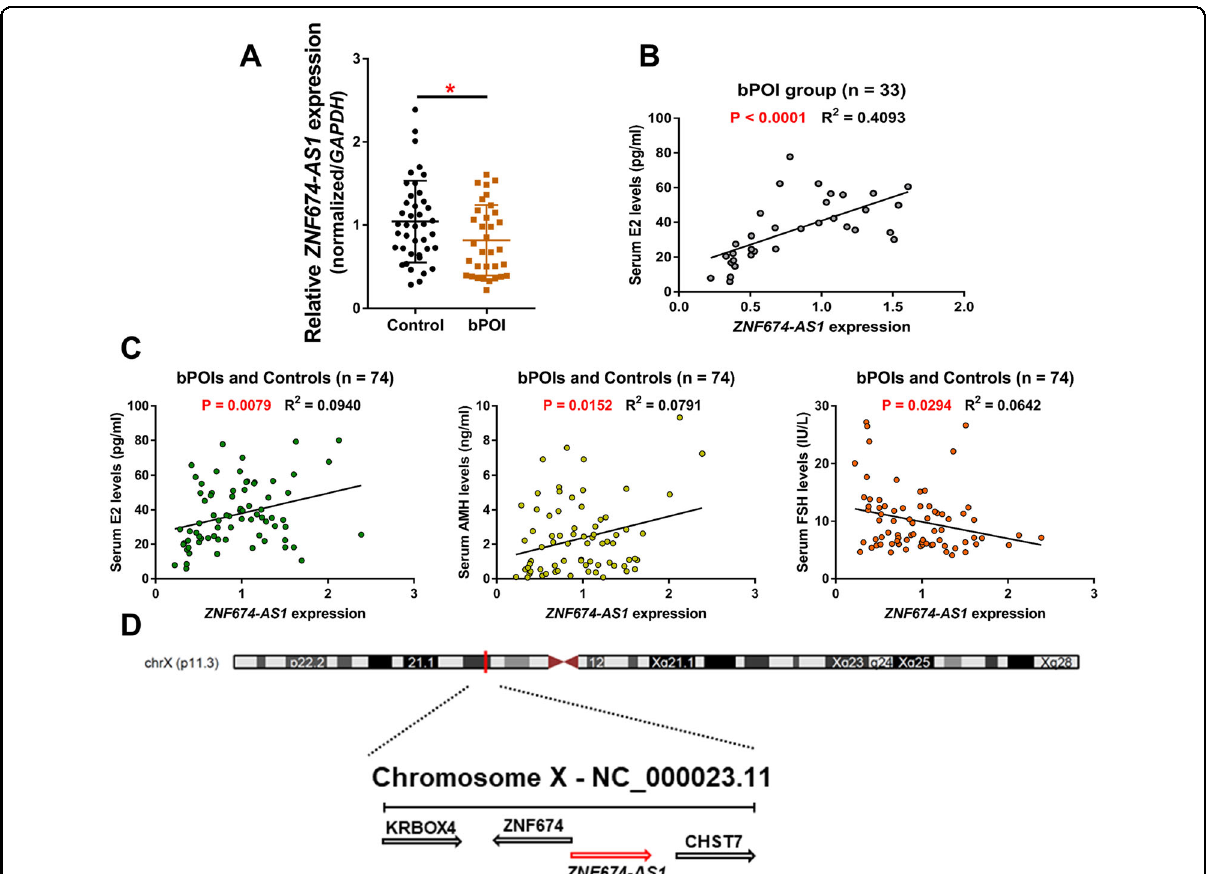
Fig. 1 LncRNA ZNF674-AS1 is down-regulated in GCs from patients with bPOI and correlates with poor ovary reserve. A The expression level of ZNF674-AS1 was validated by qRT-PCR in GCs from patients with bPOI ( n = 33) and controls ( n = 41). Ct values were normalized to GAPDH. * p < 0.05, by two-tailed Student ’ s t test. B The correlation between the expression level of ZNF674-AS1 in GCs and the serum concentration of estradiol from patients with bPOI ( n = 33) was analyzed by Pearson correlation analysis. C The correlation between the expression level of ZNF674-AS1 in GCs and the serum concentration of estradiol, AMH, FSH from all participants ( n = 74) was analyzed by Pearson correlation analysis. D Schematic representation of localization of ZNF674-AS1 in chromosome